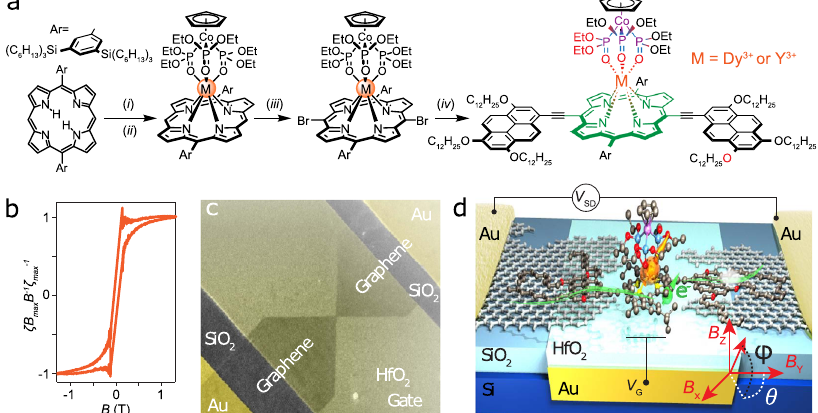
Fig. 2 The molecules and the nanodevices. a Scheme of the synthesis of the rare-earth porphyrin molecular complex, MP . M can be Y 3 + (no exchange coupling) or Dy 3 + (introducing the spin exchange). The redox-active porphyrin and the metal center are highlighted in green and orange, respectively. Reagents and conditions: (i) MCl 3 ·6H 2 O, imidazole, benzamidazole, Ph 2 O, 200 °C, 16 h; (ii) Na[CpCo{P(O)(OEt) 2 } 3 ], (iii) N -bromosuccinimide, CH 2 Cl 2 ; (iv) 1,3,6- tris (dodecyloxy)-8-ethynylpyrene, Pd(PPh 3 ) 4 , CuI, DIPA, 65 °C, 16 h. b Hysteresis cycle detected by cantilever-torque magnetometry at 150 mK with a fi eld-sweep rate of 0.125 T/min, showing single-molecule-magnet behavior for DyP derivative. The torque signal ζ is divided by the applied magnetic fi eld B and normalized by the high- fi eld signal ζ B max / max . c False-color SEM image of the devices, showing Au pads (yellow), the Au/HfO 2 back-gate (gray), and the graphene electrodes (darker shade). d Scheme of the experiment on DyP and the reference frame of the magnetic fi eld B (red). The Dy(III) spin center (orange) sits on the redox-active porphyrin, which spans the nanogap and exchanges electrons (green) via pyrene anchor